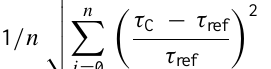
changes with respect to the error-causing input